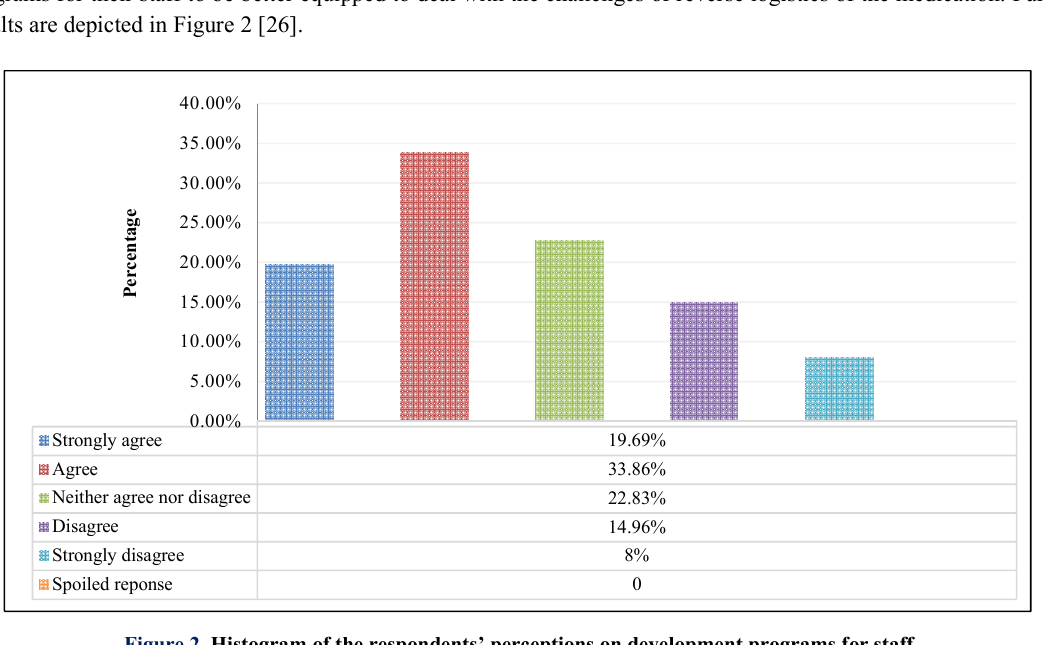
Figure 2. Histogram of the respondents’ perceptions on development programs for